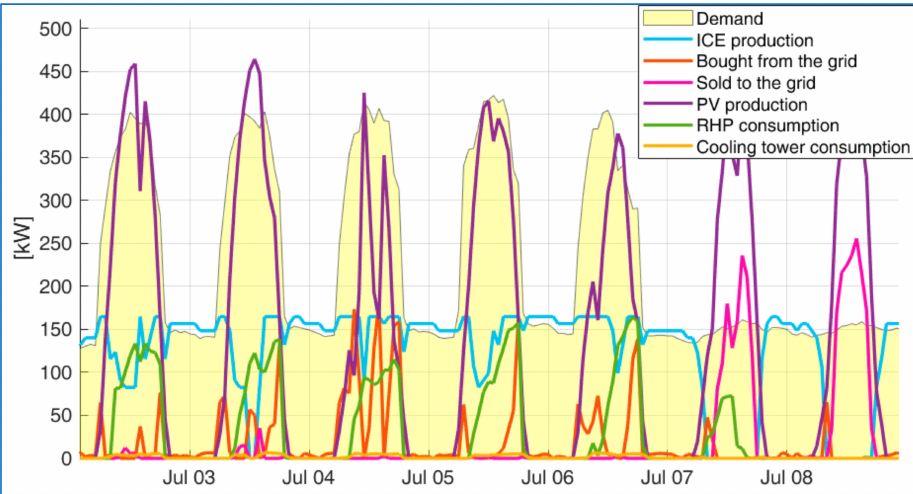
Figure 10. Optimal operation: electricity flows in a typical summer